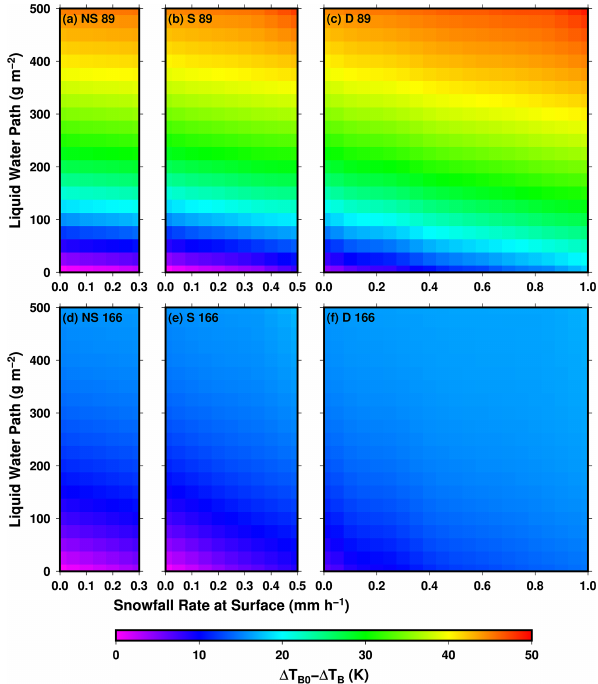
Figure 14. Simulated change of depolarization for GMI 89GHz (a, b, c) and 166GHz (d, e, f) for near-surface (a, d) , shallow (b, e) , and deep (c, f) snow clouds over ocean. Depolarization is the brightness temperature difference between vertical and horizontal polarizations. The change is relative to clear-sky